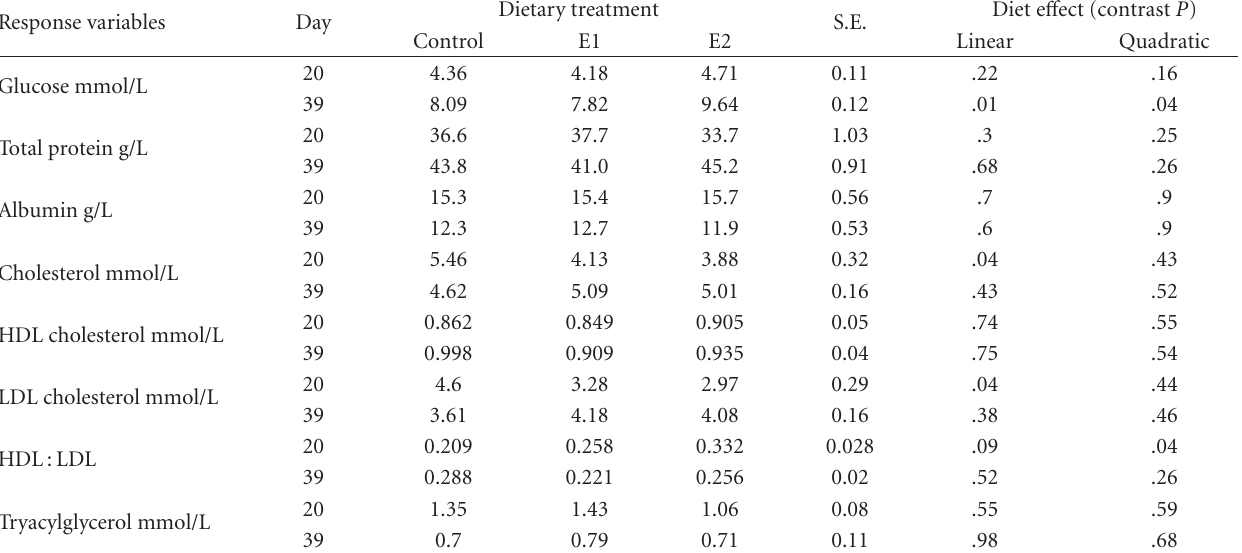
Table 7: Serum metabolite profile in broilers supplemented with graded levels of nutritional emulsifier a